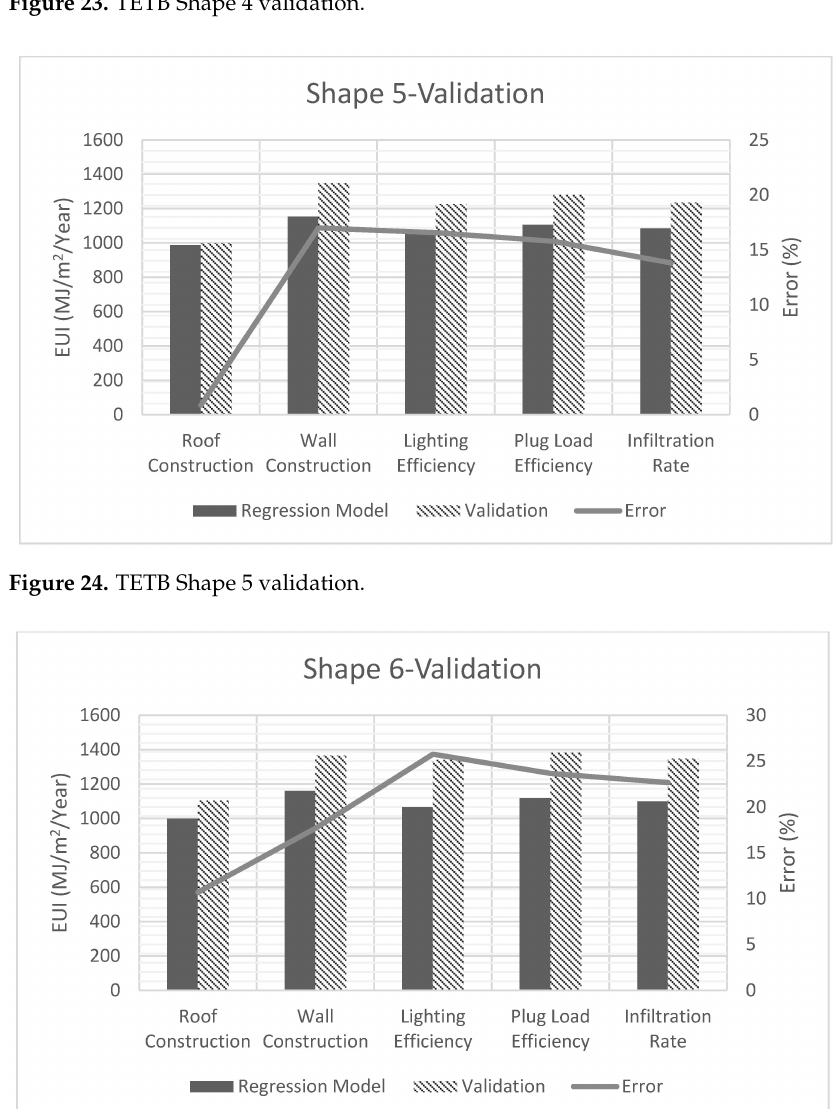
Figure 23. TETB Shape 4 validation.